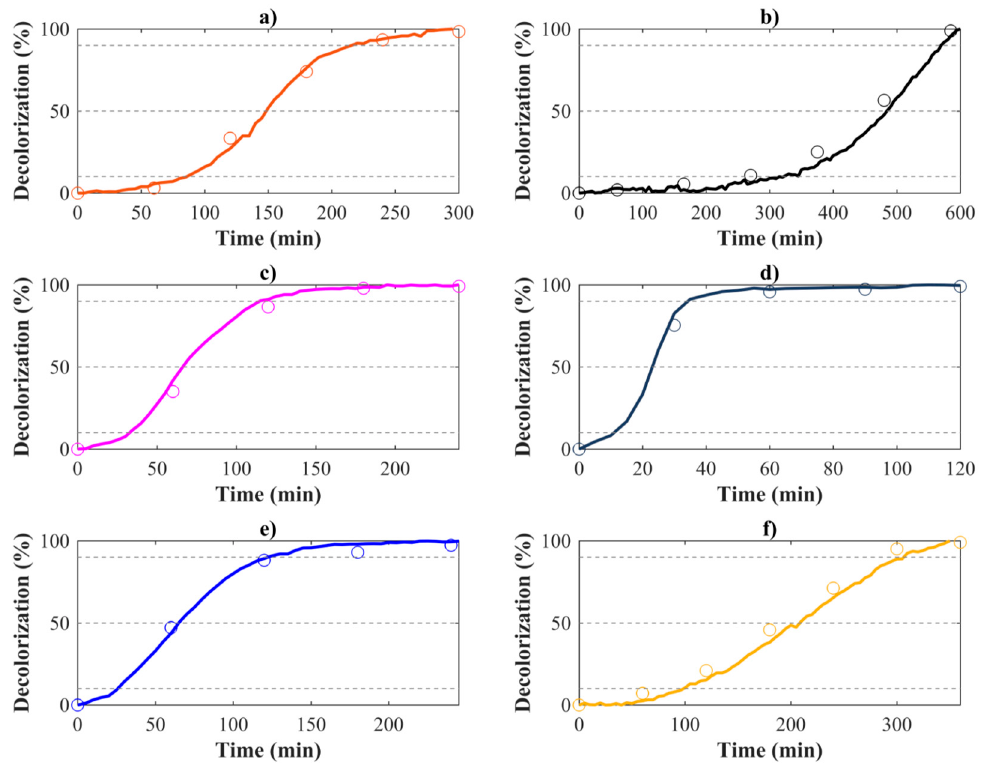
Figure 5. Decolorization of dyes, in situ and traditional method. ( a ) OP2, ( b ) RB, ( c ) PC, ( d ) PN, ( e ) PB, ( f ) PY.